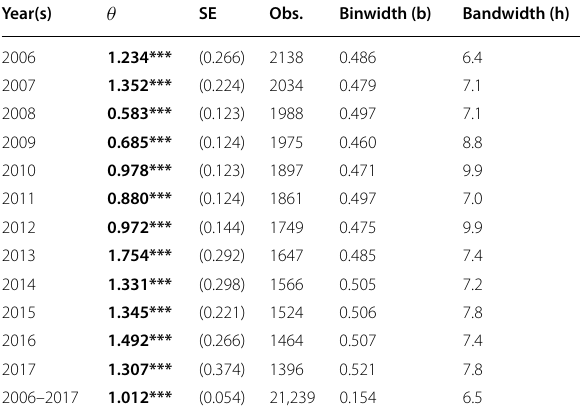
Table 6 Mc-Crary Test for Discontinuity in pension funds funding ratio at 100